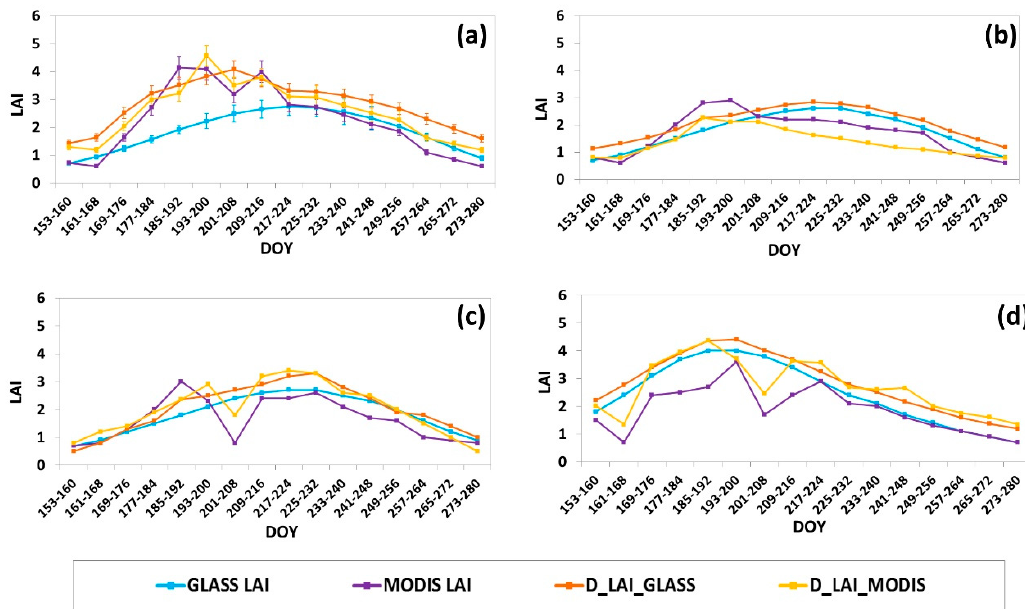
Figure 8. Comparison of MODIS FPAR, GLASS FPAR, D_FPAR_GLASS and D_FPAR_MODIS: ( a ) Cropland; ( b ) orchard; ( c ) vegetable field; ( d ) wetland. Note that the FPAR are the mean values of pixels from all sites in cropland.